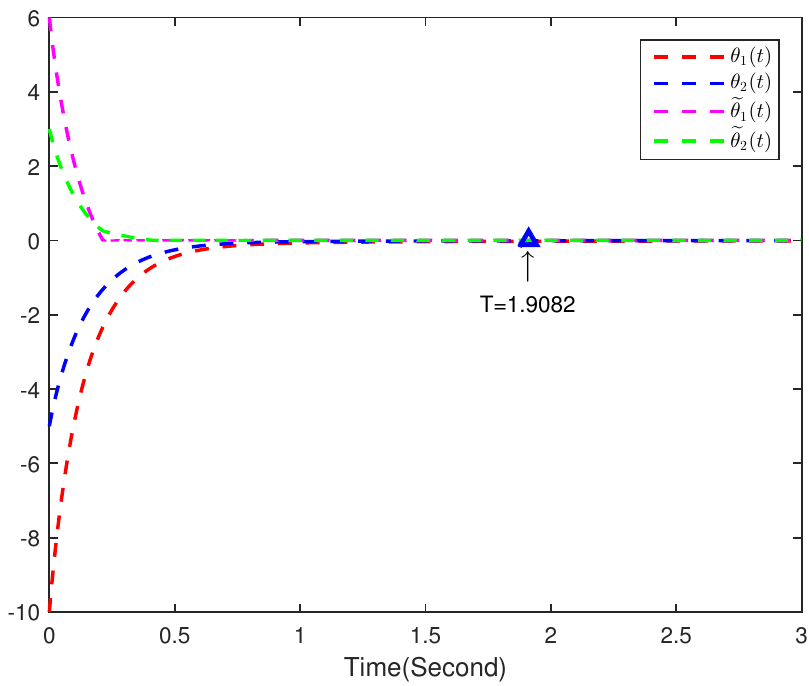
Figure 7. Synchronization error θ ( t ) and (cid:101) θ ( t ) between the drive-response